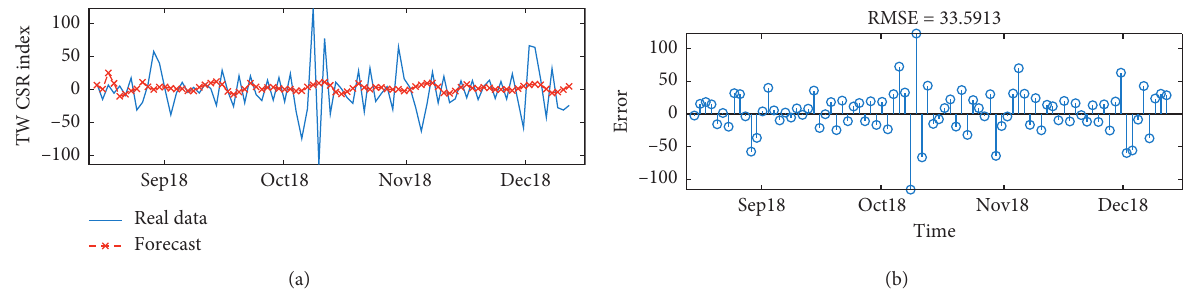
Figure 7: LSTM prediction and actual verification results for IMF1 with RMSE of 33.5913.